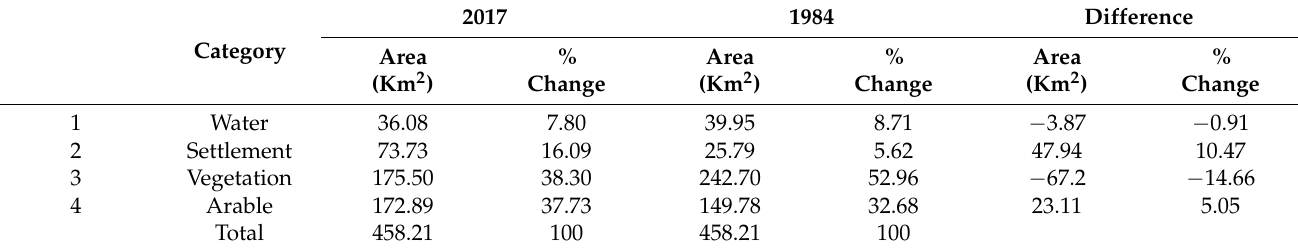
Table 3. LULC changes in (%) from